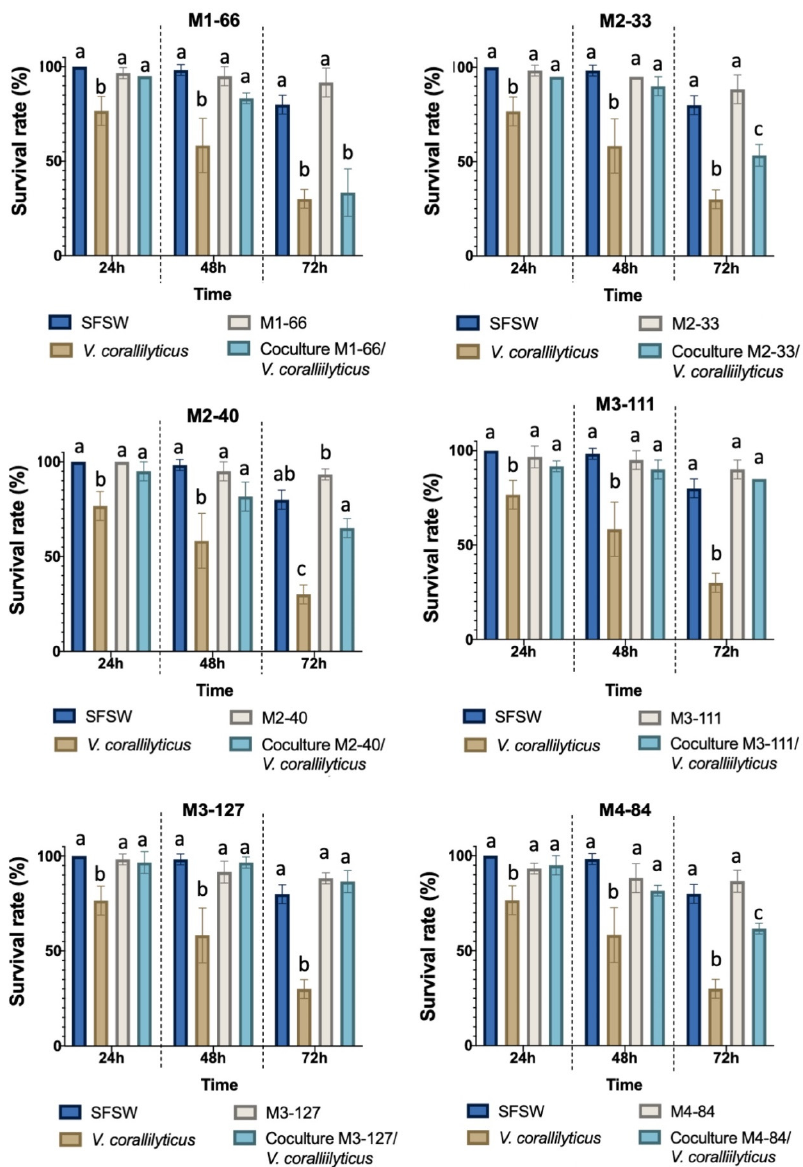
Figure 3. Survival rate of A. salina nauplii after 24 h, 48 h and 72 h of incubation with V . coralliilyticus VibC-Oc-193 in the presence or absence of AHL-degrading strains. Sterile filtered seawater (SFSW) was used as control. Different letters above the bars indicate that the values are significantly different ( p < 0.05). The statistical analysis was carried through a Tukey’s Multiple Comparison Test.